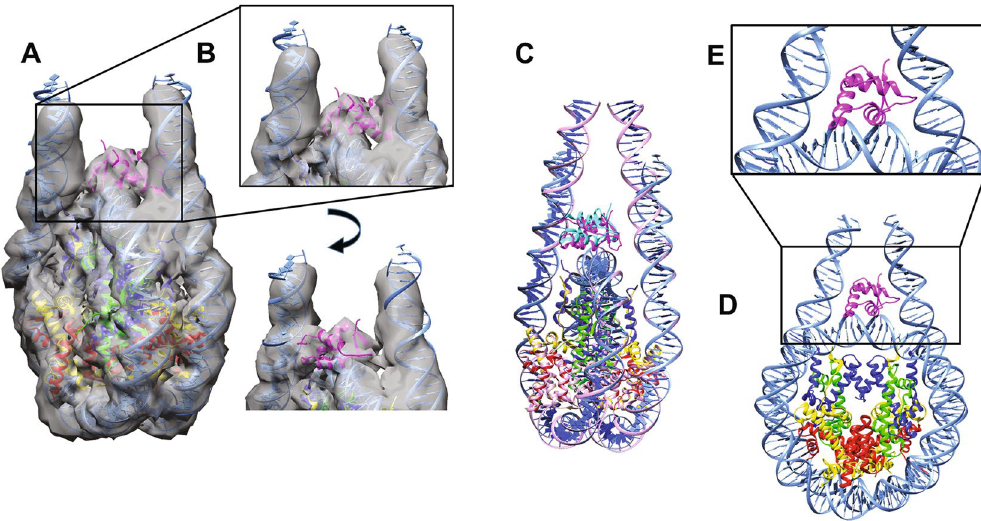
Figure 4. Cryo-EM structure of the 601–177 human chromatosome. ( A ) The model of the 601–177 chromatosome fits into the Cryo-EM map. The DNA (including linker DNA) is shown in blue. H2A is yellow, H2B is red, H3 is blue, H4 is green, and H1 is magenta. The filtered local resolution map is shown at a contour level of 0.0155. ( B ) Zoomed-in view of the region boxed in (A) showing three different views of the H1 bound to the nucleosome core particle, and fit of the H1 model into the EM map. ( C ) Comparison of the chromatosome (magenta) structure with the H1.5 bound 601–197 nucleosome in cyan (PDB entry 5NL0 30 ). ( D ) Model of the 601–177 Chromatosome. ( E ) A zoomed-in view of the region boxed in ( D ). The winged helix fold (helix turn helix) of the linker histone H1 is shown in magenta. The DNA (including linker DNA) is drawn in blue. H2A is yellow, H2B is red, H3 is blue, and H4 is green. Structures were visualised using CHIMERA 83,84,94 (www.rbvi. ucsf.edu/chime